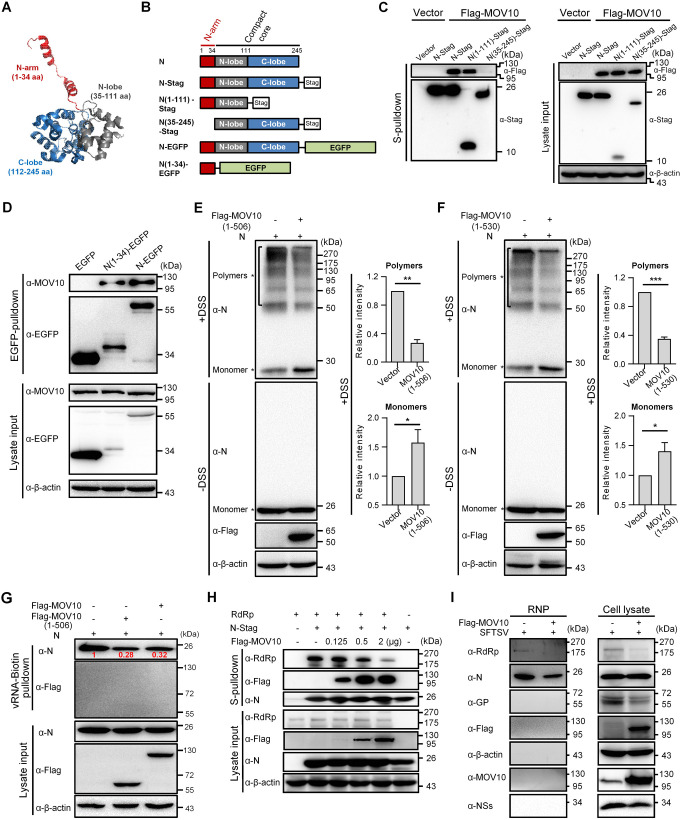
By binding to the N-arm of N, MOV10 blocks N polymerization, N-RNA binding, and N-RdRp interaction, inhibiting RNP assembly.(A) The structure of SFTSV N monomer (PDB: 4J4R). SFTSV N monomer folds into a compact core with a protruding N-arm. The core further consists of the N- and C-lobes. (B) Schematic diagram of N truncations used below. (C) HEK293T cells were cotransfected with the plasmids expressing S-tagged N mutants and Flag-MOV10 or the control vectors for 24 h and then subjected to S-pulldown and IB analyses. (D) HEK293T cells transfected with the plasmids encoding EGFP or EGFP-tagged proteins were subjected to EGFP-nanotrap and IB. (E and F) MOV10-KO HEK293T cells were transfected with the Flag-tagged MOV10(1–506) or MOV10(1–530) expression plasmids or control vector, together with the expression plasmid for SFTSV N, and cross-linked with disuccinimidyl suberate (DSS) that enables the fixation of oligomerized bunyavirus N in situ, followed by SDS-PAGE and IB analyses. Asterisks indicate N monomers and polymers based on the apparent molecular weights. The band intensities of polymers and monomers of the DSS-treated samples were quantified using ImageJ software and then the relative intensities (over the controls without MOV10(1–506) or MOV10(1–530) expression) were respectively calculated and shown in the graphs beside the representative IB results. Data are means ± SD, n = 3. (G) HEK293T cells were transfected with the indicated protein expression plasmids before the pulldown assay using biotin-labeled in vitro transcript of SFTSV RNA and streptavidin-coupled beads. The cell lysate inputs and pulldown products were then analyzed by IB. Band intensities of RNA-bound N were quantitatively measured with the ImageJ software and indicated in the blot after normalization to the control without Flag-MOV10 or Flag-MOV10(1–506) expression. (H) HEK293T cells were transfected with plasmids encoding RdRp and N-stag, together with increasing amounts of Flag-MOV10 expression plasmid, and then subjected to S-pulldown and IB. (I) HEK293 cells transfected with Flag-MOV10 or vector were infected with SFTSV (3 MOI), followed by extraction of RNP from cell lysates at 24 hpi. The cell lysates and extracted RNP were respectively subjected to IB with the indicated antibodies. See also S8, S9 and S10 Figs.